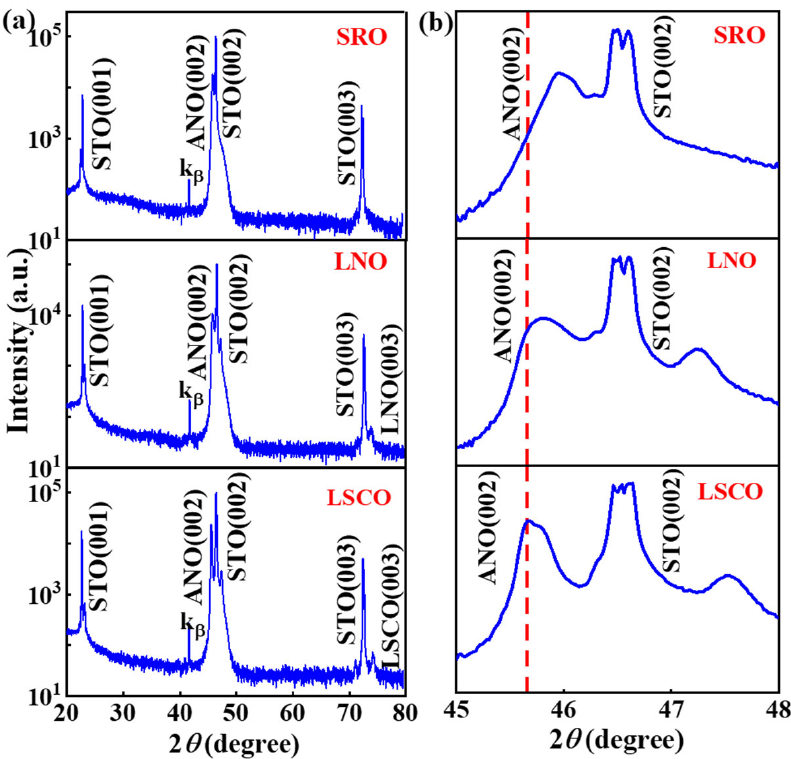
Figure 1. XRD patterns ( a ) and magnified (002) peaks ( b ) of ANO films grown on LSCO, LNO and SRO bottom electrodes.